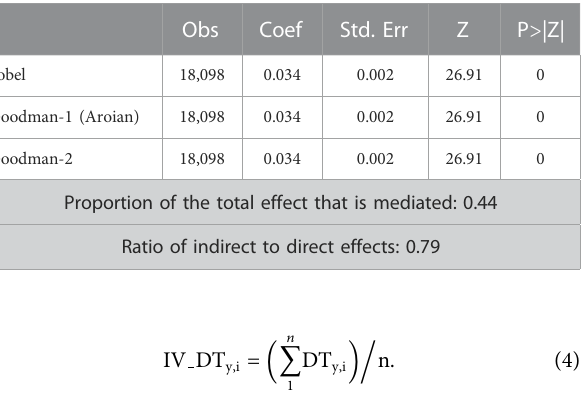
TABLE 4 Regression analyses. TABLE 5 Sobel test